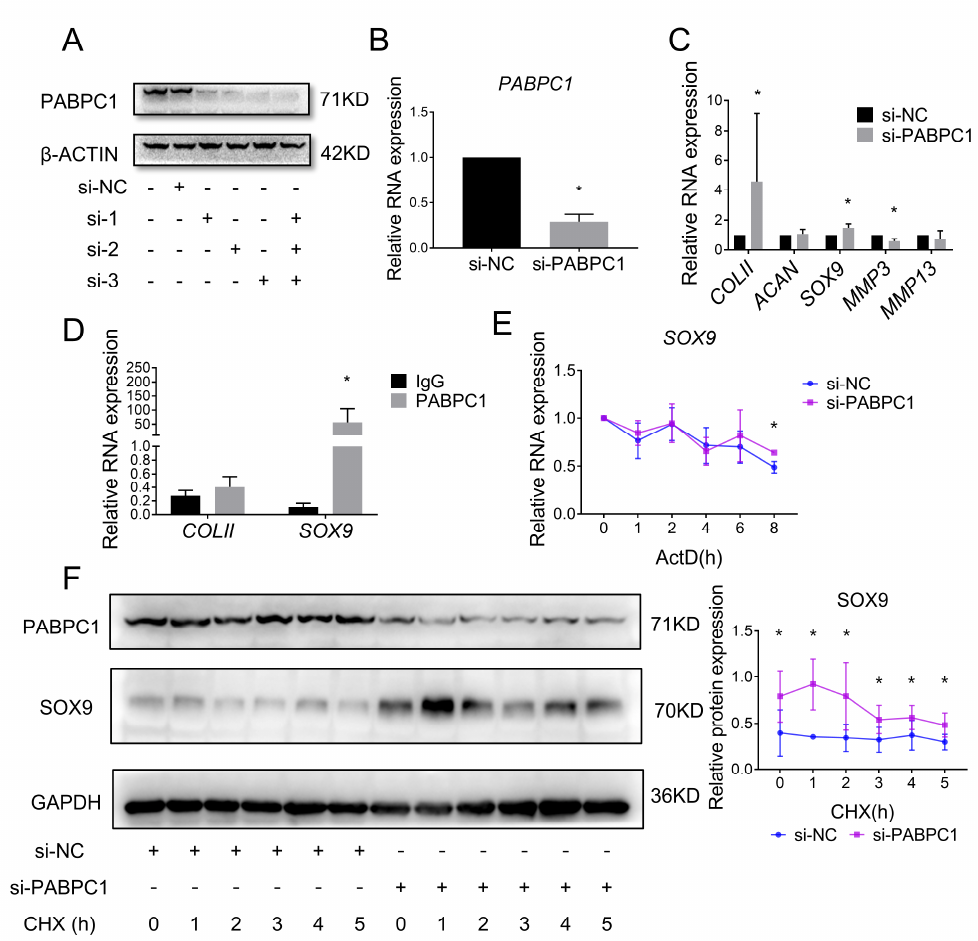
Figure 6. Silencing PABPC1 suppresses cartilage ECM degradation. ( A ) Western blot analysis showed PABPC1 protein levels after transfection of SW1353 cells with three siRNAs (50 nM) targeting endogenous PABPC1 alone or in combination. ( B ) Expression of PABPC1 mRNA levels were determined by RT-qPCR in SW1353 cells after PABPC1 knockdown using siRNA pool (si-PABPC1, a combination of three siRNAs (50 nM)). ( C ) Expression of COLII, ACAN, SOX9, MMP3, and MMP13 mRNA levels were determined by RT-qPCR in SW1353 cells after PABPC1 knockdown. ( D ) RT-qPCR from RIP analysis showed COLII and SOX9 mRNA in PABPC1 immunoprecipitates and IgG (control) from SW1353 lysates. ( E ) RT-qPCR showed that the inhibition of PABPC1 increased the mRNA stability of SOX9. SW1353 cells were treated with actinomycin D (ActD, 5 μg/mL) at different time points 48 h after PABPC1 knockdown. ( F ) Western blot analysis showed that inhibition of PABPC1 increased the protein stability of SOX9. SW1353 cells were treated with cycloheximide (CHX, 50 mg/mL) at different time points 48 h after PABPC1 knockdown. * p < 0.05, si-PABPC1 vs. si-NC ( B , C ), PABPC1 vs. IgG ( D ), si-PABPC1 vs. si-NC ( E , F ) at the same time point are compared. The measurement data are expressed as the mean ± standard deviation, and were analyzed by Mann–Whitney U test. The experiments were repeated three